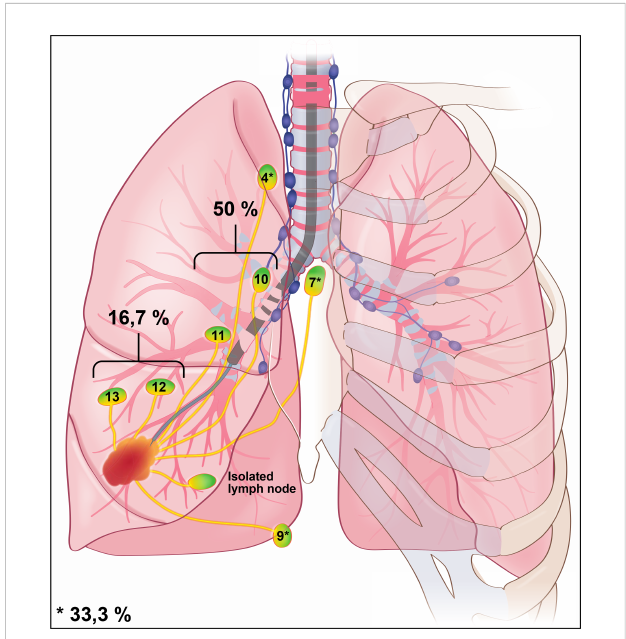
FIGURE 2 Illustration of peri-tumoral ENB ICG injection. Disclosed percentages represent data for the whole cohort (regardless the location of the tumor). The percent of cases according to the location (mediastinal, hilar, scissural or iLN) is speci fi ed (in the majority of cases the lymph node is single (90%). 18/54 mediastinal (33.3%), 27/54 hilar (50%), 9/54 scissural and iLN